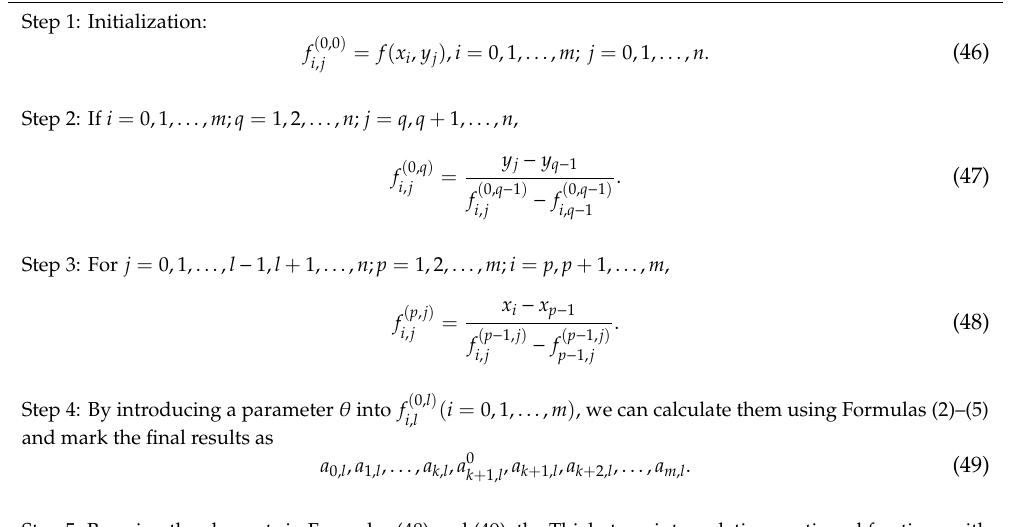
Algorithm 5 Algorithm of the dual bivariate Thiele-like branched rational interpolation continued fractions with a single